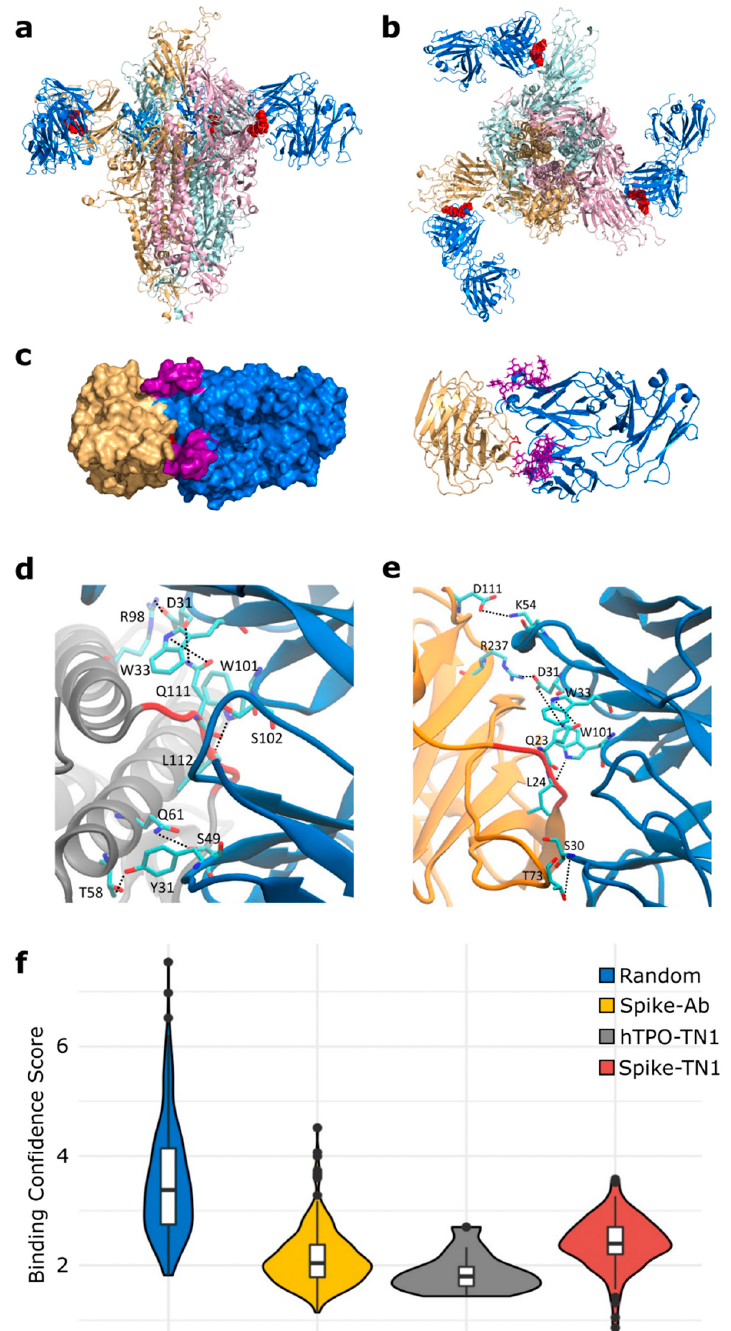
Figure 4. Binding of SARS ‐ CoV ‐ 2 Spike to TN1 Fab antibody. Equilibrated structure (1 ns) of the modeled TN1 Fab antibody (blue, PDB id: 1V7M) complexed with Spike trimer model (pink, beige, light blue) shown from ( a ) the side and ( b ) the top, with TQLPP shown as red spheres. ( c ) The Spike NTD (beige) and TN1 Fab complex used for MD simulations (200 ns), with adjacent glycans at N17 and N74 highlighted in purple. The representative amino acids contributing to hydrogen bonds (dashed lines) during the last 50 ns of simulations for the ( d ) hTPO ‐ TN1 and ( e ) Spike ‐ TN1 com ‐ plexes are highlighted as cyan sticks. ( f ) Violin plot showing the distribution of the MaSIF binding confidence scores for randomly selected patch pairs (blue), the interacting region of Spike ‐ antibody (yellow) and hTPO ‐ TN1 (gray) complexes, and for modeled Spike ‐ TN1 complexes across 40 Spike configurations (red). Statistical analysis with Mann ‐ Whitney U shows that all pairwise comparisons except for Spike ‐ Ab and hTPO ‐ TN1 are significantly different after Bonferroni correction (Table S6).